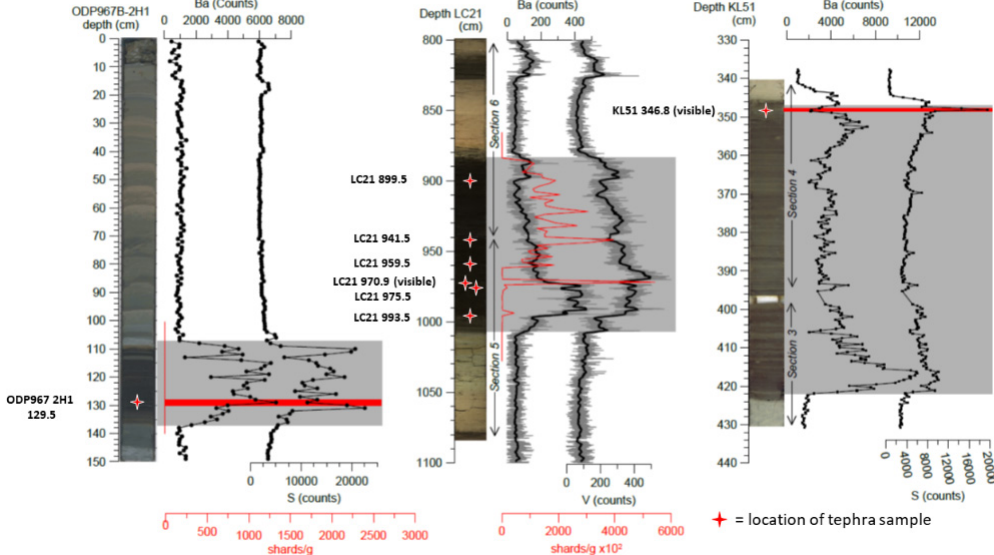
Figure 2. Tephra samples (red stars) taken from sapropel S5 in Eastern Mediterranean marine cores ODP967B-2H1, LC21, and KL51. Scanning X-ray fluorescence (XRF) profiles and grey shading indicate the position of S5, after [21,22] and [60]. Ba, S and V are shown because they best delineate the depth range of the sapropel. Note that no Sulphur data are available for LC21, so the similarly redox-sensitive Vanadium is used instead. A 21-point running average (black) is superimposed on the raw data for LC21. Glass shards were counted in the cryptotephra layers of ODP 967B (vertical red line indicates the interval sampled, horizontal red line indicates location and concentration of the single sample containing shards; the cryptotephra deposit) and LC21 (cryptotephra shard concentrations shown by red line), whereas KL51 contains only a 5 mm thick visible tephra layer (red horizontal line); no cryptotephra investigation was undertaken on this core. LC21 also contains a 2 mm thick visible tephra layer at 970.9 cm depth, previously described in [17]. Down-core depths are